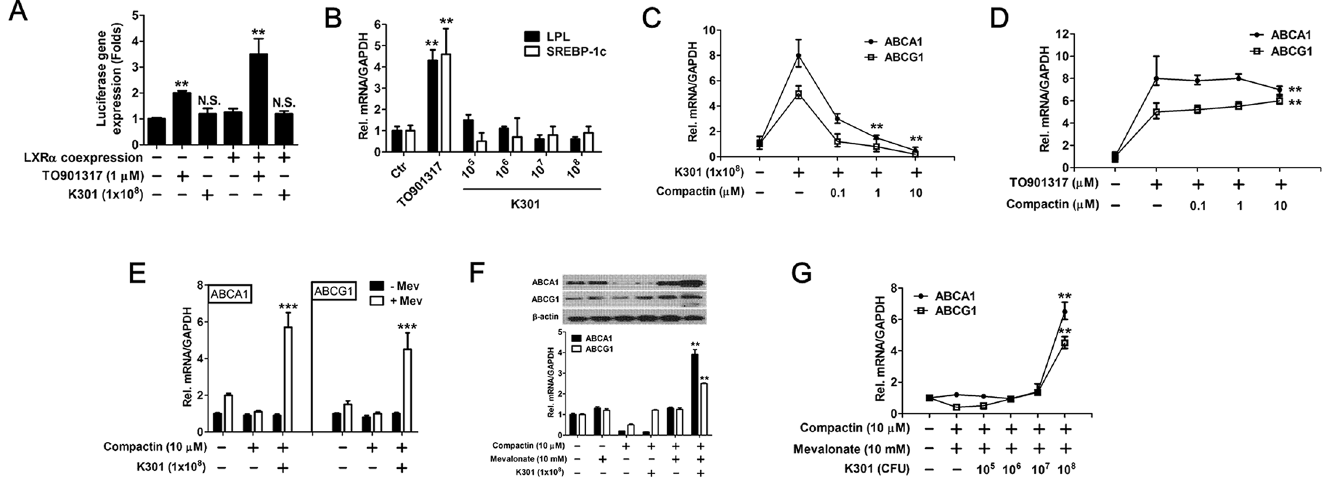
Fig 2. L . acidophilus K301-mediated ABCA1 and ABCG1 expression was associated with intracellular cholesterol synthesis. (A) Reporter assay of LXR agonistic activity of heat-killed LAB. A firefly luciferase reporter gene containing the human LXR binding site of the ABCA1 promoter was constructed and transfected into HEK293 cells together with an expression vector containing human LXR- α . The reference plasmid pRL-SV40 was also co-transfected. Cells were stimulated with 1×10 8 heat-killed L . acidophilus K301 or TO901317. Firefly luciferase activity was measured and normalized to Renilla luciferase activity. (B) PMA differentiated macrophages were stimulated with the indicated dose of heat-killed L . acidophilus K301 and mRNA expression of LPL and SREBP-1c was examined by real-time PCR. (C, D) Cells were treated with heat-killed L . acidophilus K301 (C) or with TO901317 (D) in the presence of compactin. mRNA expression of ABCA1 and ABCG1 was examined by real-time PCR. (E) Cells were stimulated with heat-killed L . acidophilus K301 in the presence of compactin and 10 mM mevalonate. ABCA1 and ABCG1 mRNA level was examined by real-time PCR. (F) Cells were stimulated with heat-killed L . acidophilus K301 in the presence of compactin and 10 mM mevalonate. The protein level of ABCA1 and ABCG1 was examined by western blotting, and corresponding densitometry data are shown (low panel). (G) Cells were stimulated with the indicated dose of heat-killed L . acidophilus K301 with 10 μ M compactin and 10 mM mevalonate. The mRNA level of ABCA1 and ABCG1 was examined by real-time PCR. β -actin was used as a protein loading control; mRNA expression of genes was normalized to GAPDH . Results are the means of three independent experiments (mean ± S.D). ** P < 0.01; *** P < 0.001 vs. untreated cells. The error bars in individual samples are shown as variations from triplicate assays.